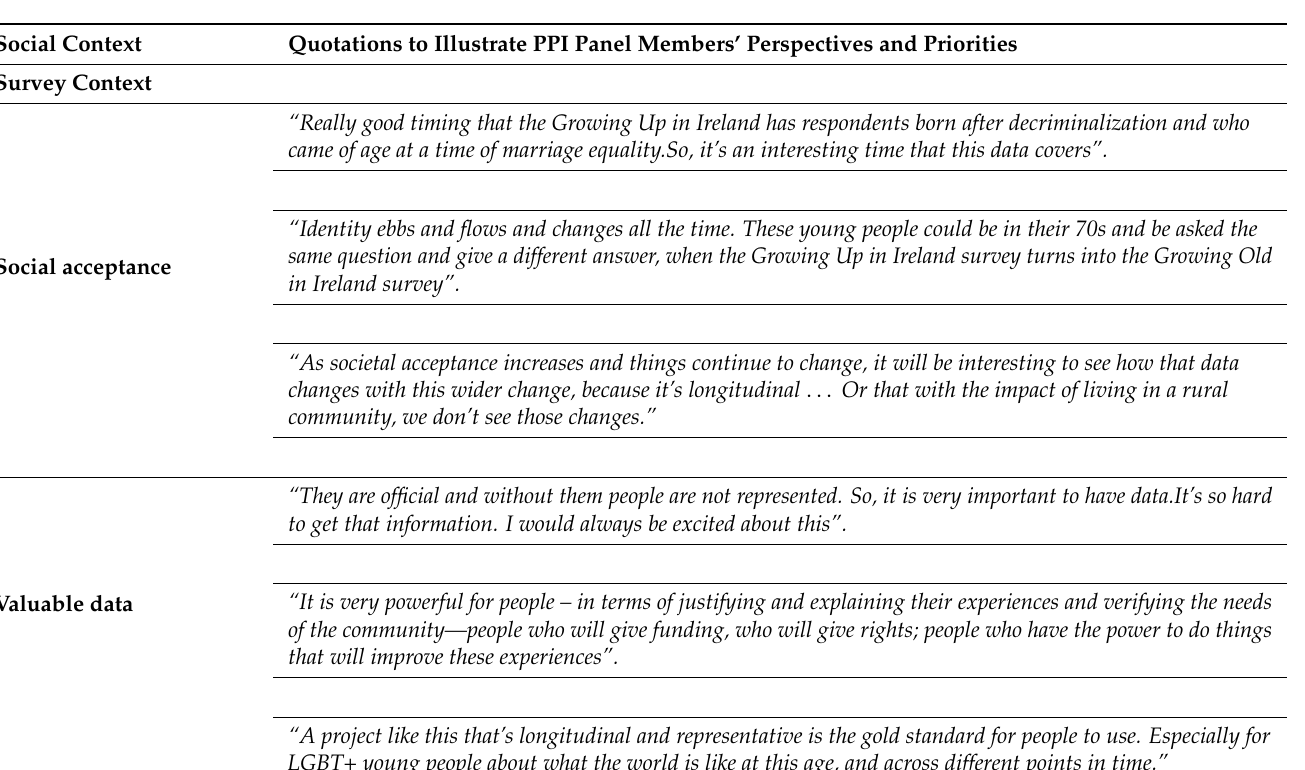
Table 2. PPI Panel members’ reflections on the social context for the Growing Up in Ireland